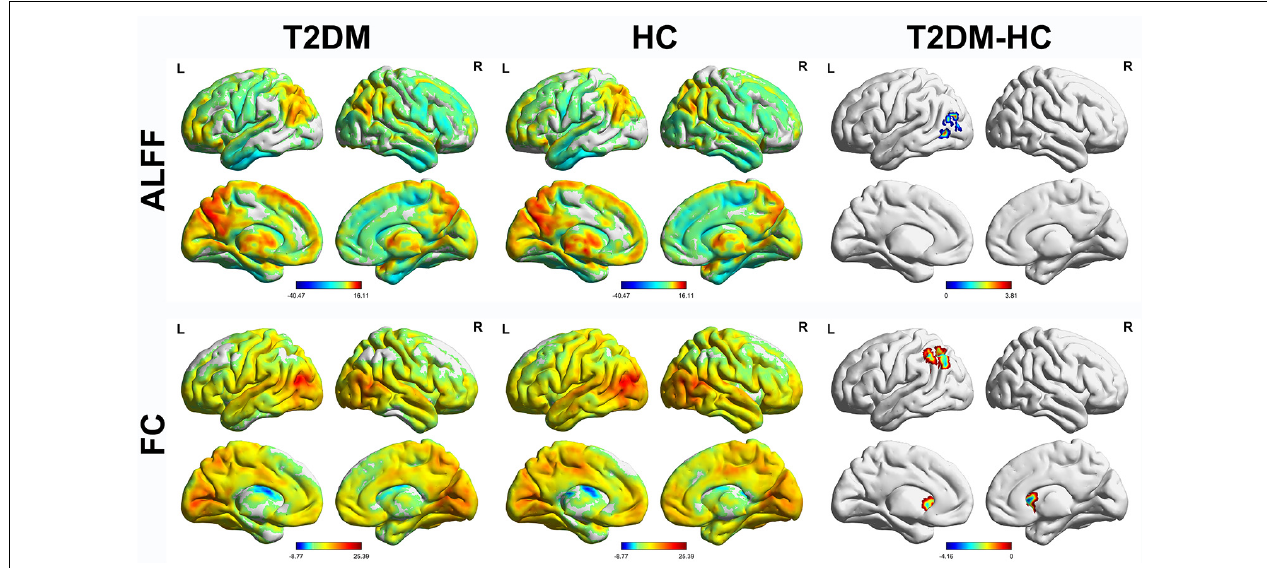
FIGURE 1 | Amplitude of low-frequency fluctuations (ALFF) and functional connectivity (FC) distribution of intra-group (one-sample t -test) and inter-group comparisons (two-sample t -test). p < 0.05 (corrected with Gaussian random-field theory). The color bar denotes the t -value. R, right; L, left.